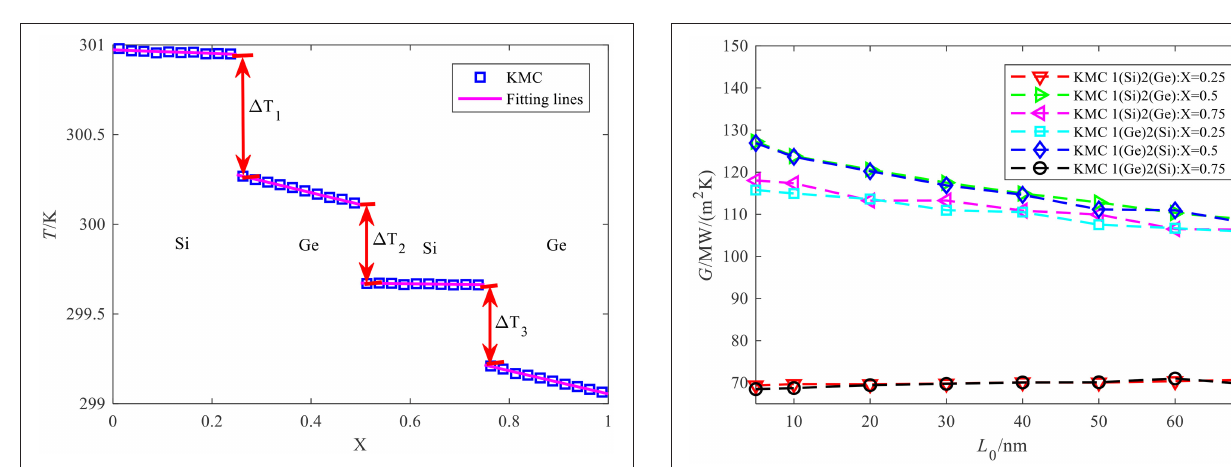
FIGURE 7 | The thermal boundary conductance of three interfaces for different material collocations vs. the thickness of one layer of the multilayer system: the red dash line with the down triangle is the result of non-dimensional position coordinates X at 0.25 for 1(Si) and 2(Ge) collocation; the green dash line with the right triangle is the result of non-dimensional position coordinates X at 0.5 for 1(Si) and 2(Ge) collocation; the magenta dash line with the left triangle is the result of non-dimensional position coordinates X at 0.75 for 1(Si) and 2(Ge) collocation; the blue-green dash line with the square is the result of non-dimensional position coordinates X at 0.25 for 1(Ge) and 2(Si) collocation; the blue dash line with the diamond is the result of non-dimensional position coordinates X at 0.5 for 1(Ge) and 2(Si) collocation; the black dash line with the circle is the result of non-dimensional position coordinates X at 0.75 for 1(Ge) and 2(Si)